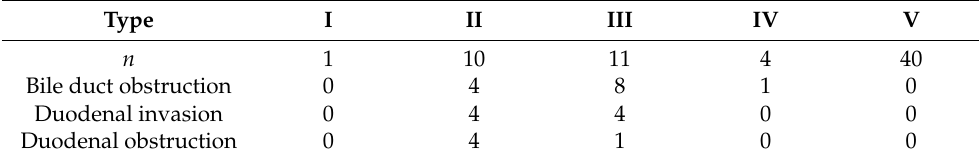
Table 7. The classification of 66 cases of PDAC in the non-dilatation group using our classification method.